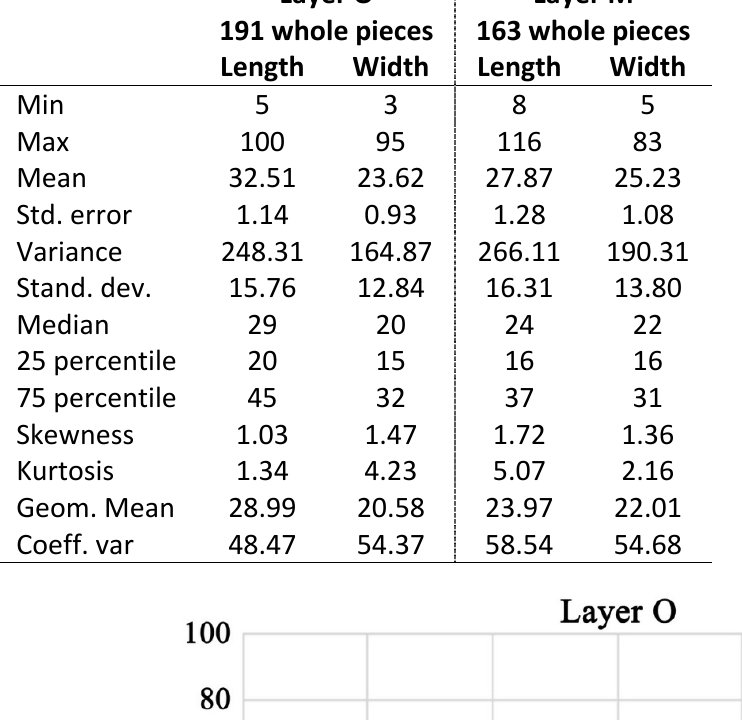
Table 3. Length and width, summary statistics. Fragmented elements were not been counted. Measurements are in millimetres.